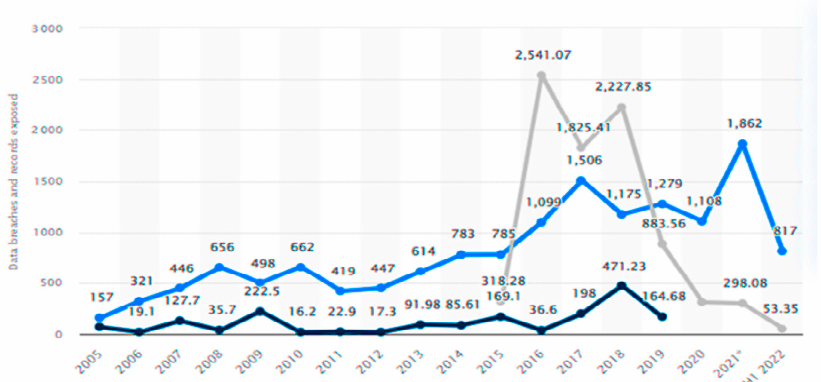
Figure 2. Data Breaches in Past Years on Statista [1]. Reprinted/adapted with permission from Ref. [1]. Copyright 2022, Statista. * shows forecasts. Ref. [1]. Copyright 2022, Statista. * shows